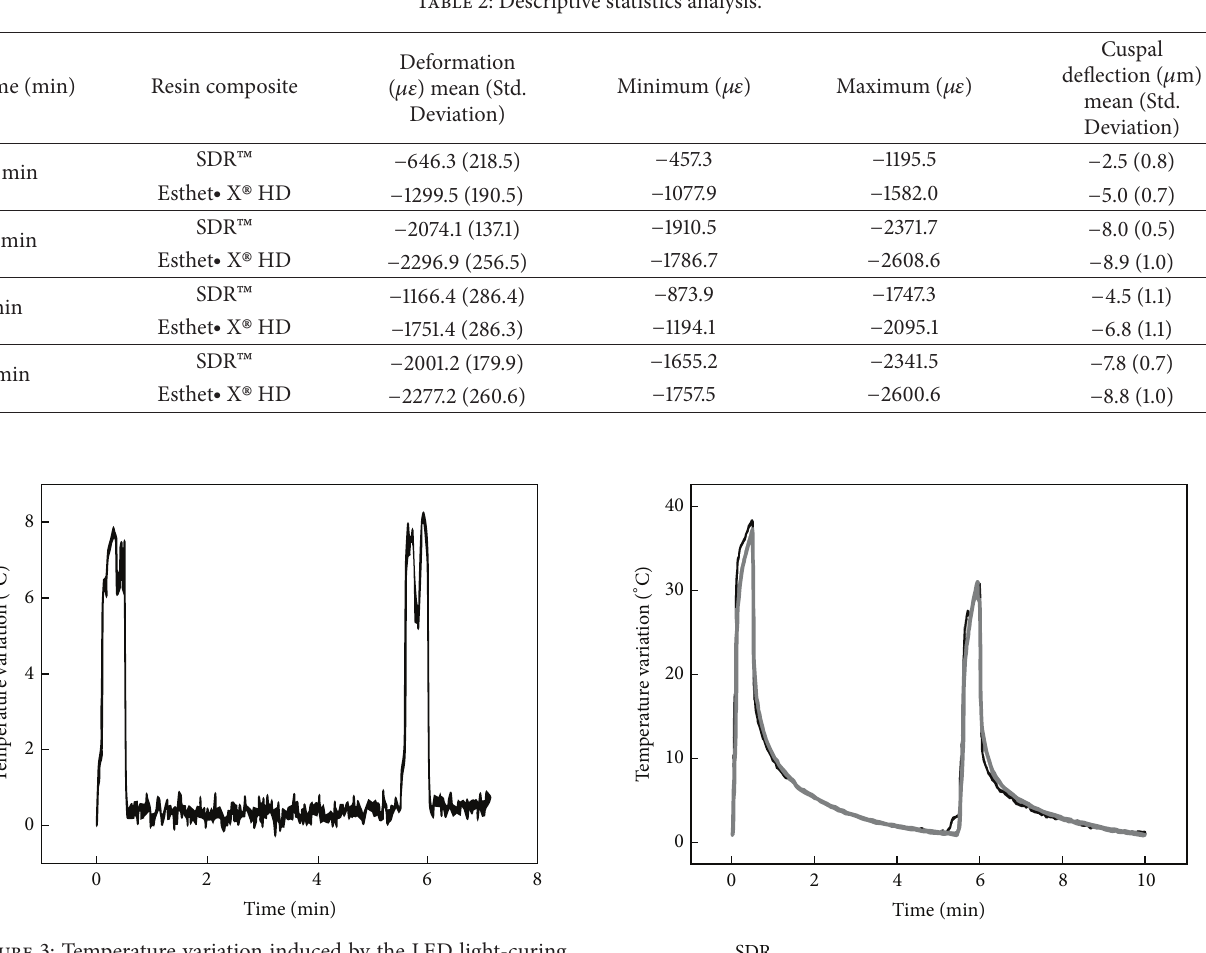
Table 2: Descriptive statistics analysis.